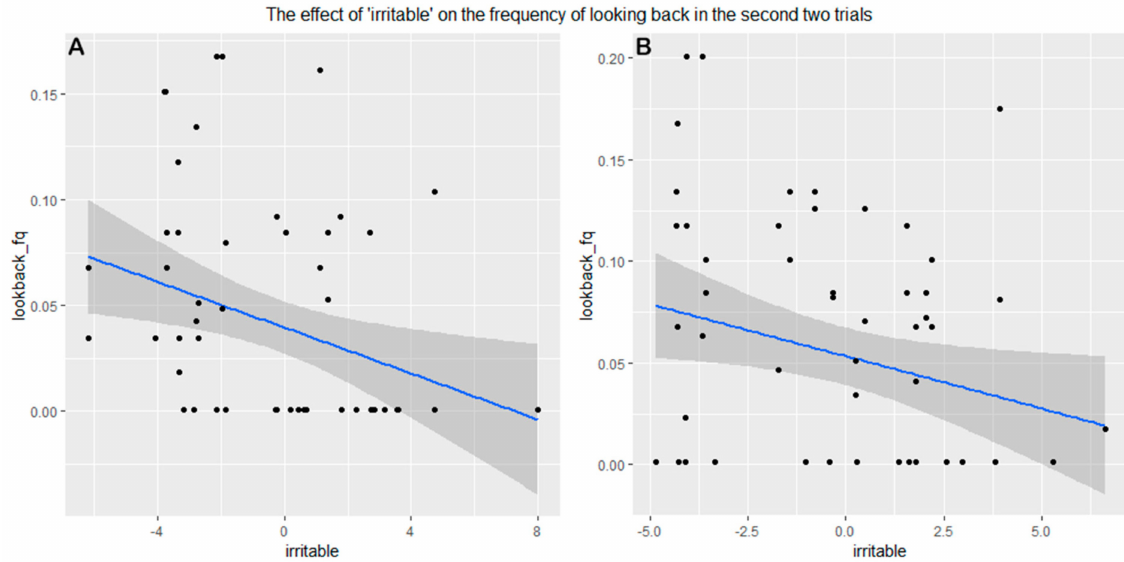
Figure 6. More “irritable” dogs looked back less frequently at the owner in the second and third trials in both the ( A ) experimenter demonstration group and ( B ) owner demonstration